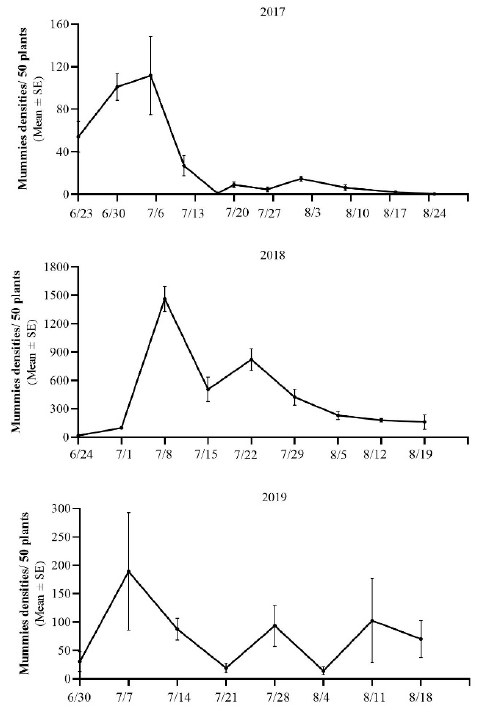
Figure 2. Dynamics of the mummy population in the cotton fields from 2017 to 2019.